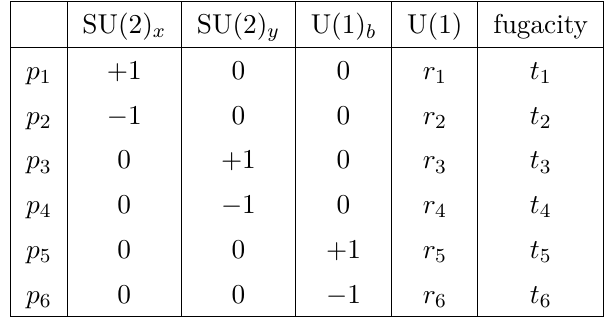
Table 23 . Global symmetry charges on the extremal brick matchings p i of Model